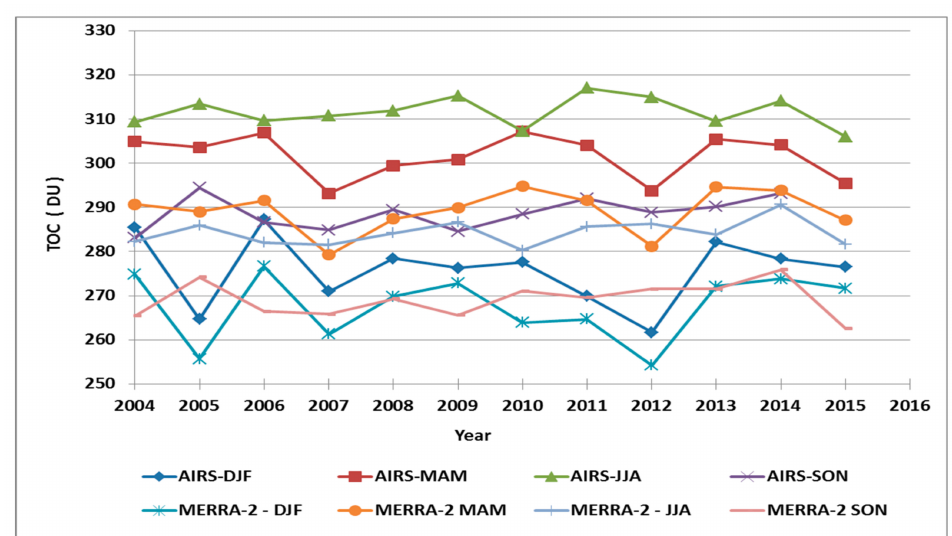
Figure 4. Seasonal monthly average time series of TOC in Dobson Unit (DU) over Egypt (2005–2016) from AIRS and MERRA-2.